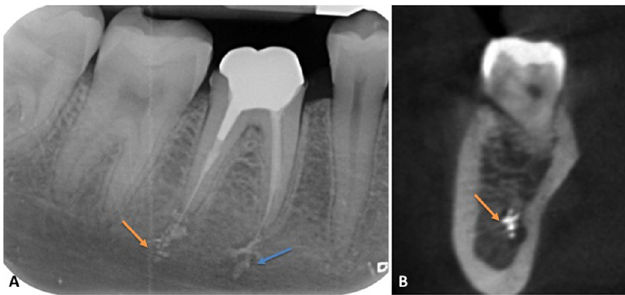
Figure 3. A. Periapical radiograph of tooth 46 showing the over fi lling on the mesial and distal roots near the mandibular canal (blue and orange arrows respectively). B. Coronal CBCT slice centered on the distal root of tooth 46 showing the over fi lling extending into the mandibular canal (same orange arrow as in A.).